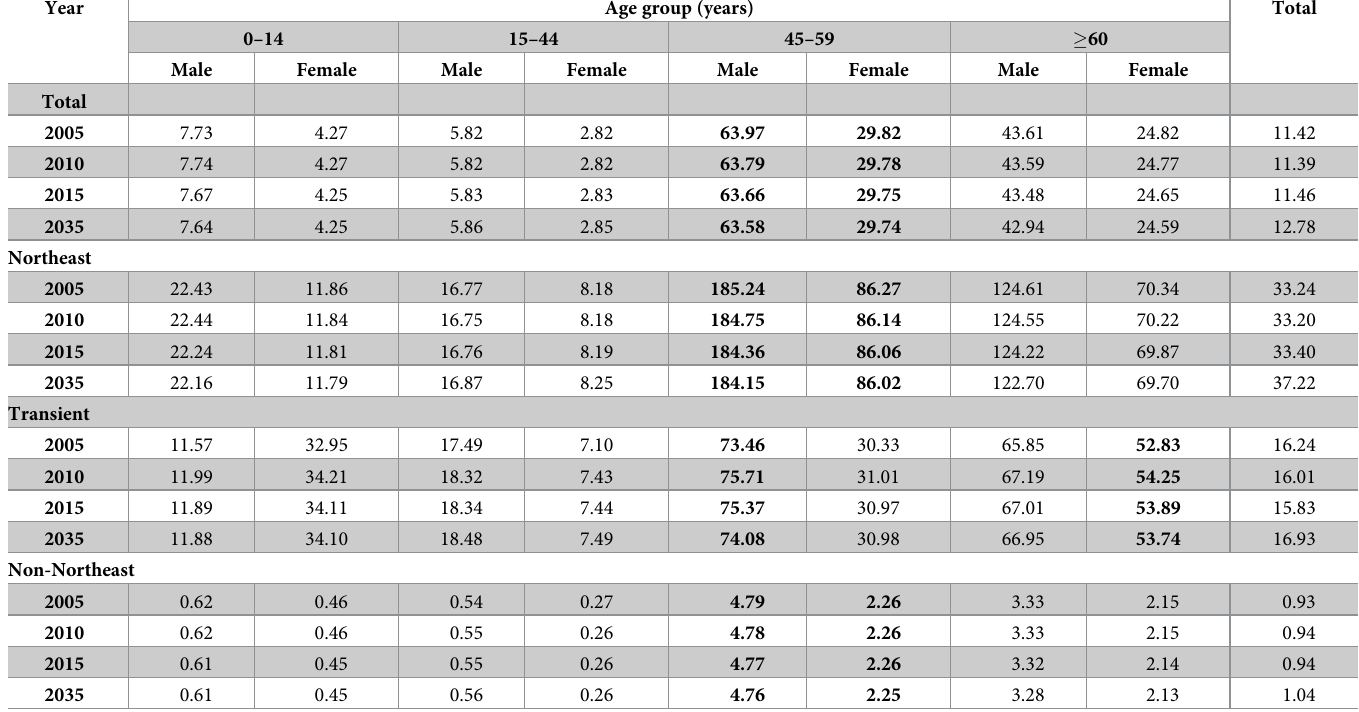
Table 2. Projection of melioidosis incidence rates per 100,000 people in males and females by age group for selected years in each